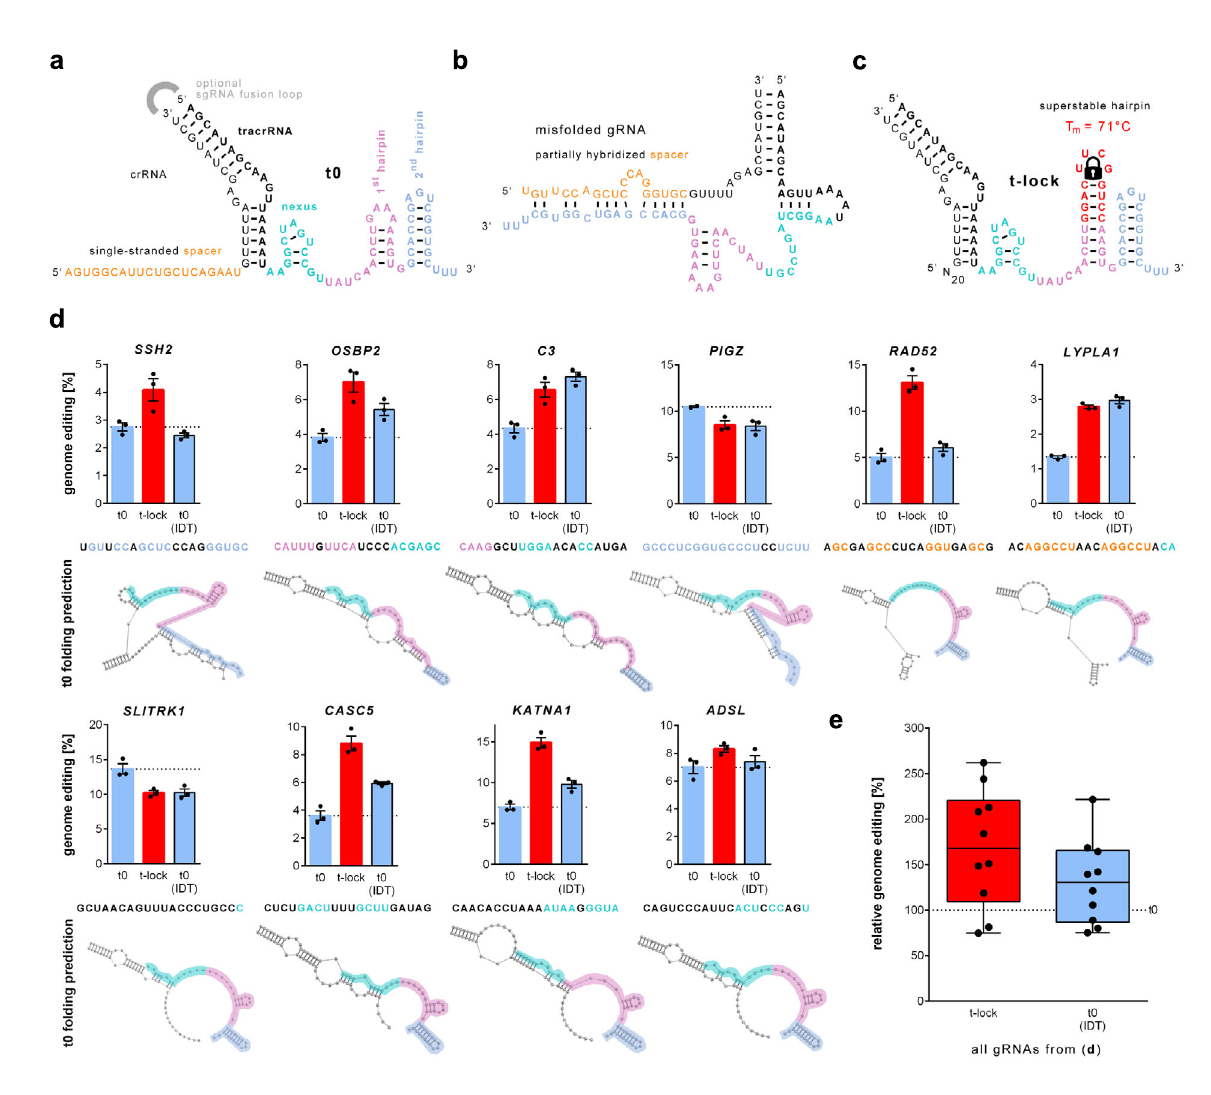
Fig. 1 Genome editing ef fi ciencies of gRNAs with an engineered tracrRNA backbone. a gRNA (hybridized crRNA:tracrRNA) from S. pyogenes for a canonically folded gRNA; and b a predicted non-canonical folded gRNA ( SSH2 ). The spacer sequence, as well as the structural motifs nexus, 1st hairpin, and 2nd hairpin are shown. c Locked tracrRNA (t-lock) gRNA design carrying an elongated 1st hairpin with a superstable loop that should serve as a gRNA folding nucleation site and prevent misfolding. d Genome editing ef fi ciencies for t0 (normal), t-lock (red), and commercial t0 (IDT) (black frame). t0 (IDT) dots ( n = 3, except PIGZ t0 n = 2) and the error bars show the SEM. The panels show the ef fi ciencies for 10 different gRNAs with different predicted